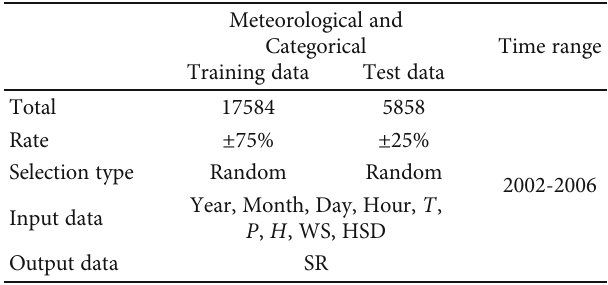
Table 2: Basic structure of the training and test input data determined hourly to be used in